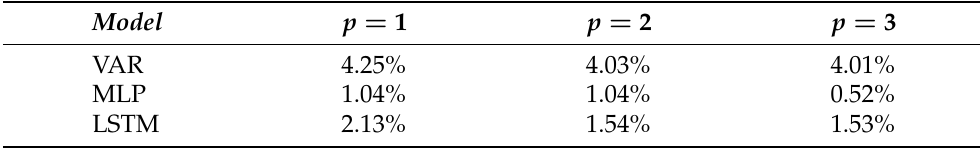
Table 1. Percentage of the NFT collections for which the null hypothesis H 0 can be